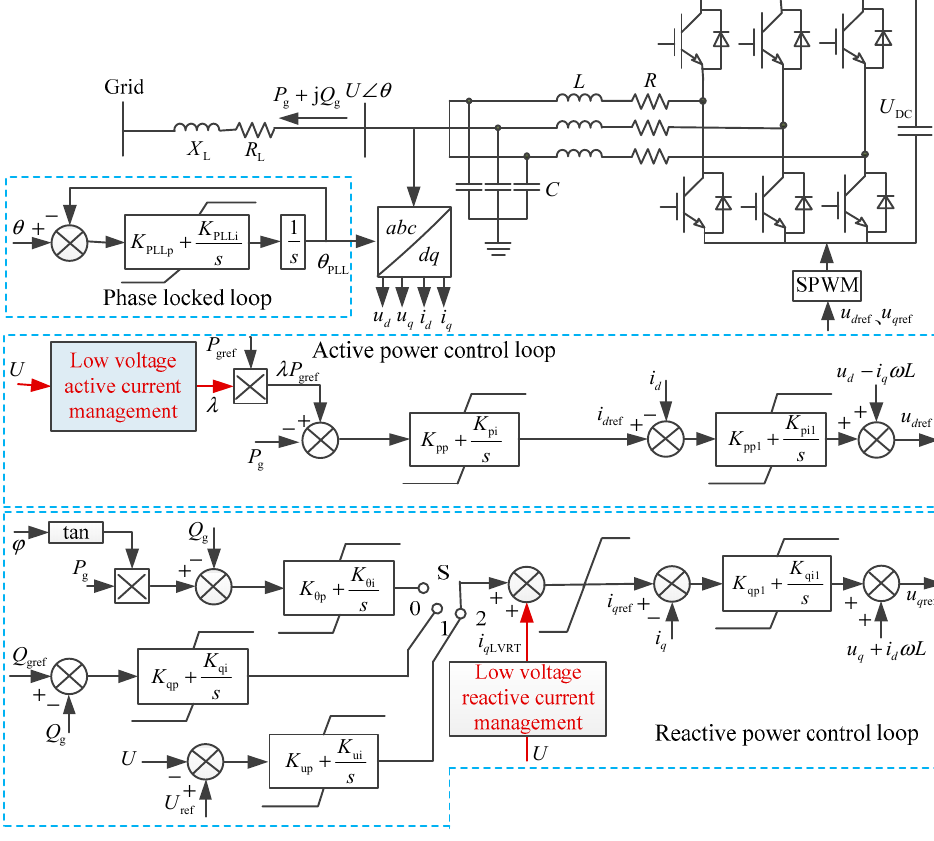
Figure 3. A reduced order model structure for various types of renewable DGs.